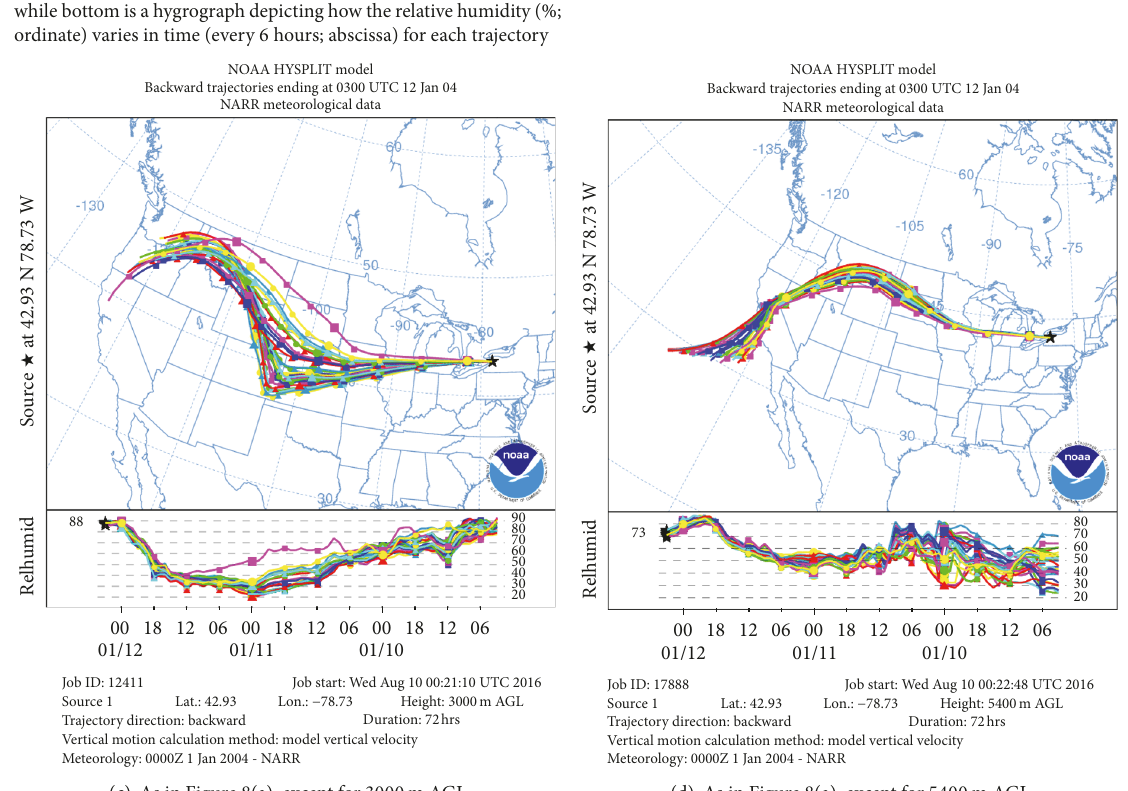
(b) As in Figure 8(a), except for 1500m